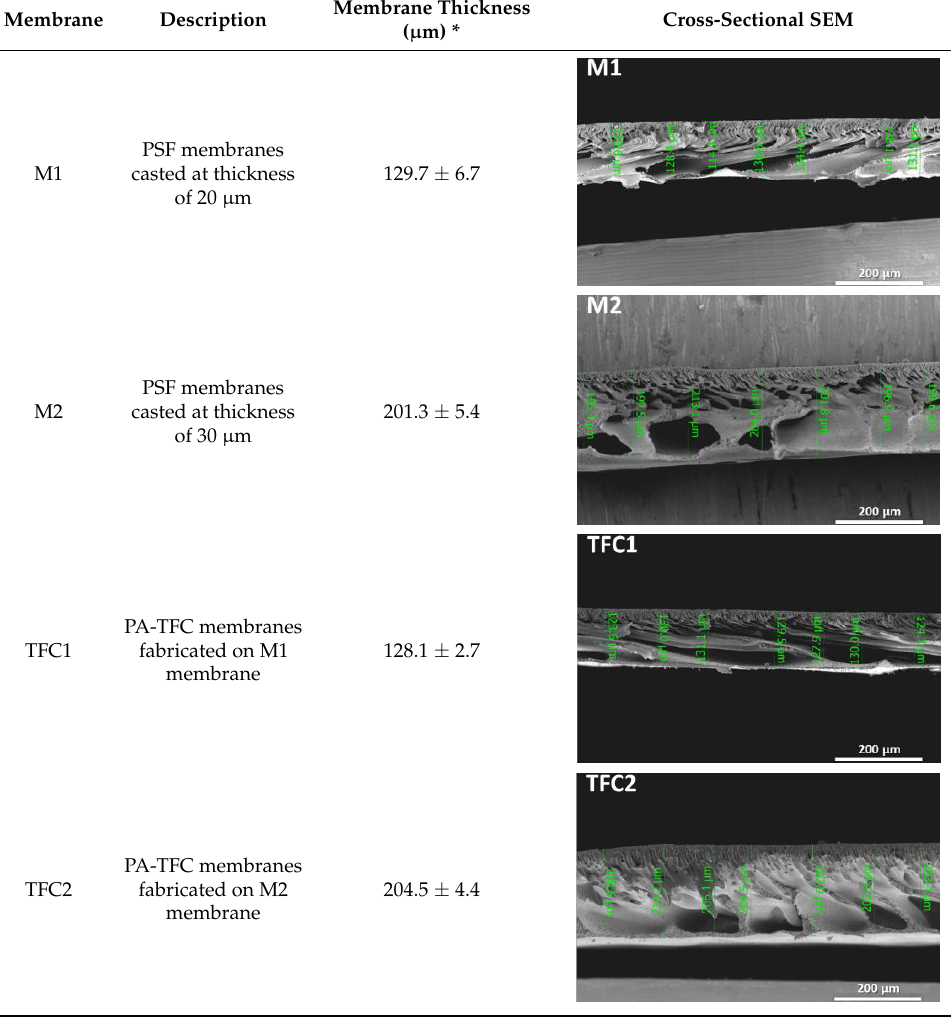
Table 2. Schematic illustration of the types of the tested membranes.